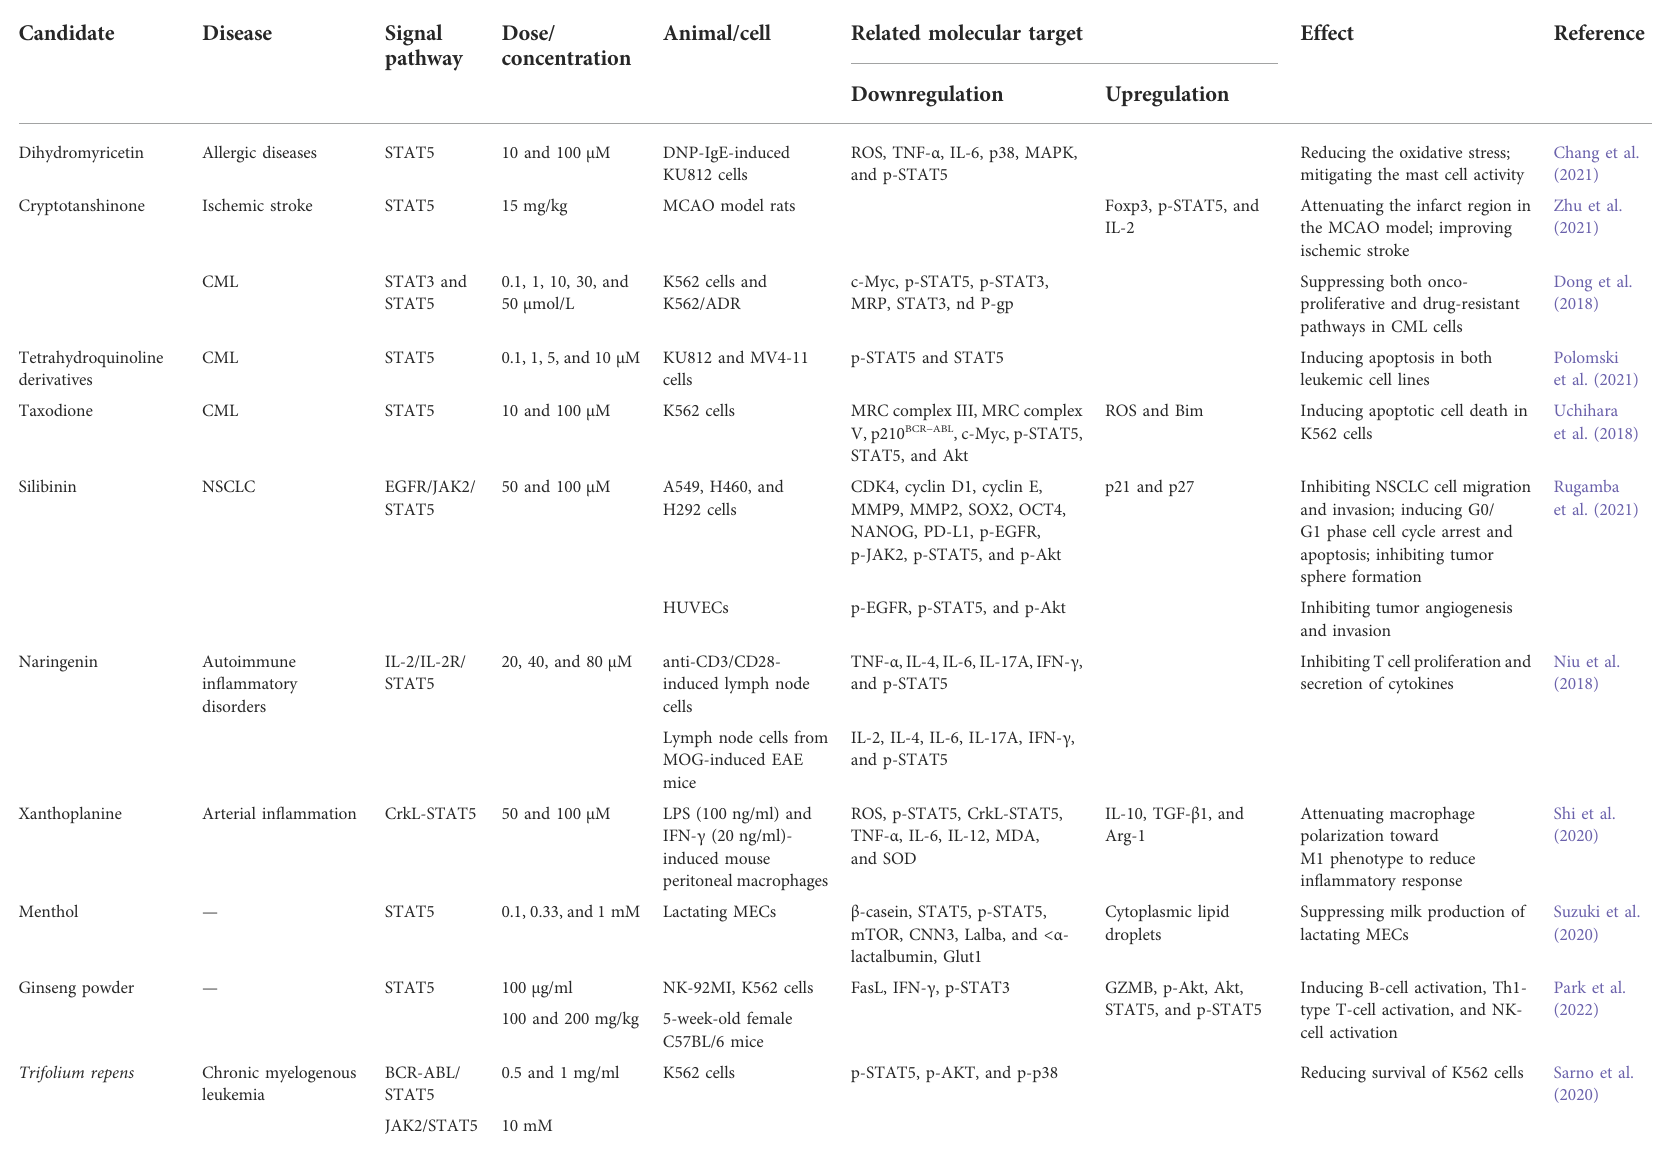
TABLE 5 Chinese herbs and herb formulas, natural compounds, and phytochemicals in the treatment of diseases through regulating